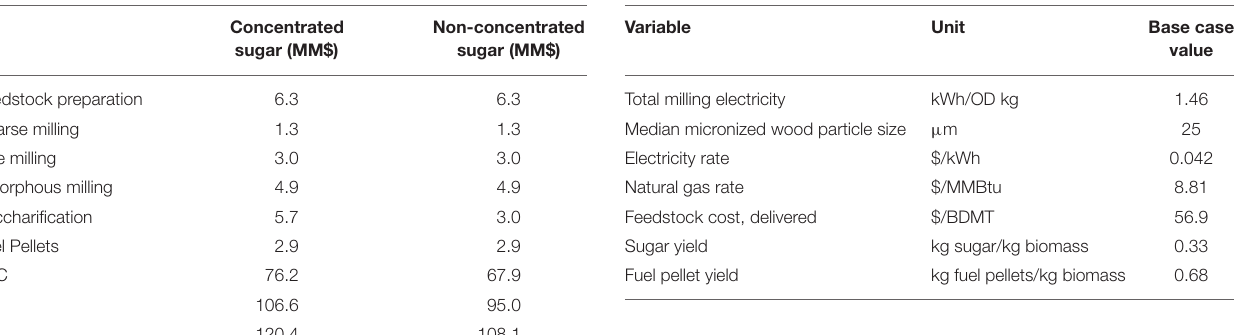
TABLE 2 | Capital costs for concentrated and non-concentrated sugar facilities. TABLE 3 | Base case variables for micronized and saccharification